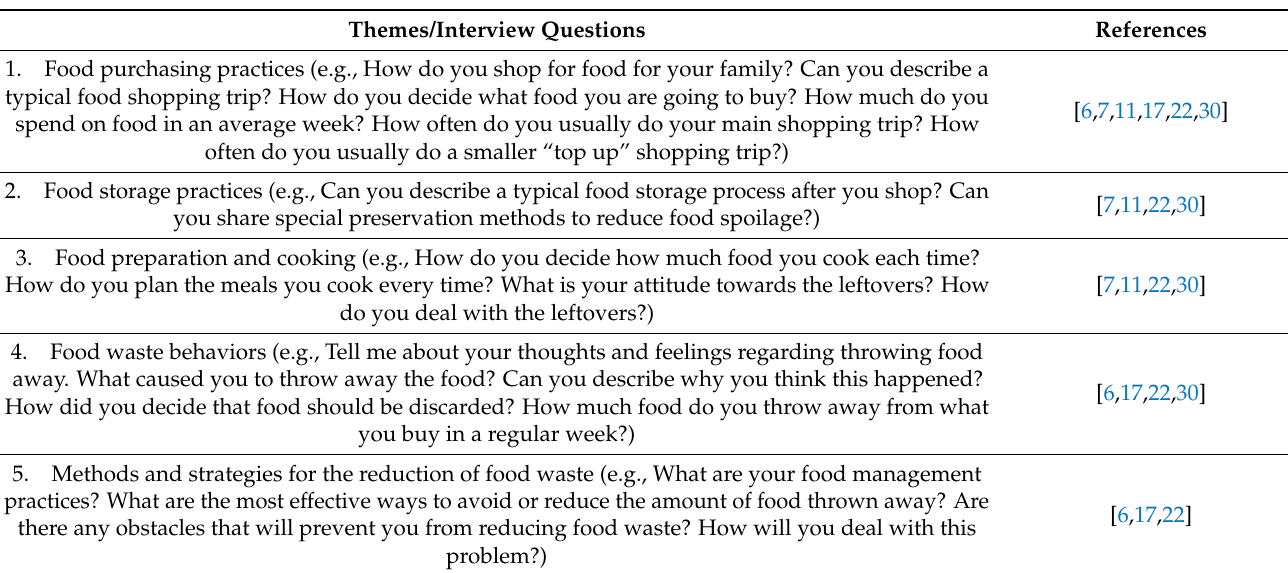
Table 3. Interview questions and their links to the extant